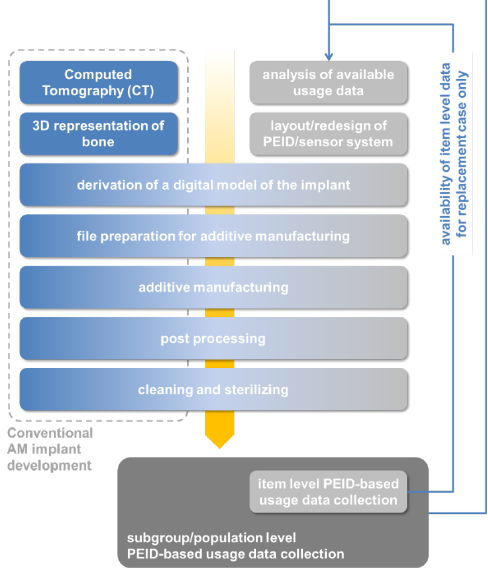
Figure 9. Typical design flow for implant layout according to Cronskär et al. [121] with additions introduced by a PLM-data supported approach combining item and subgroup/population level information. The diagram assumes PEID integration as integral part of the AM process.